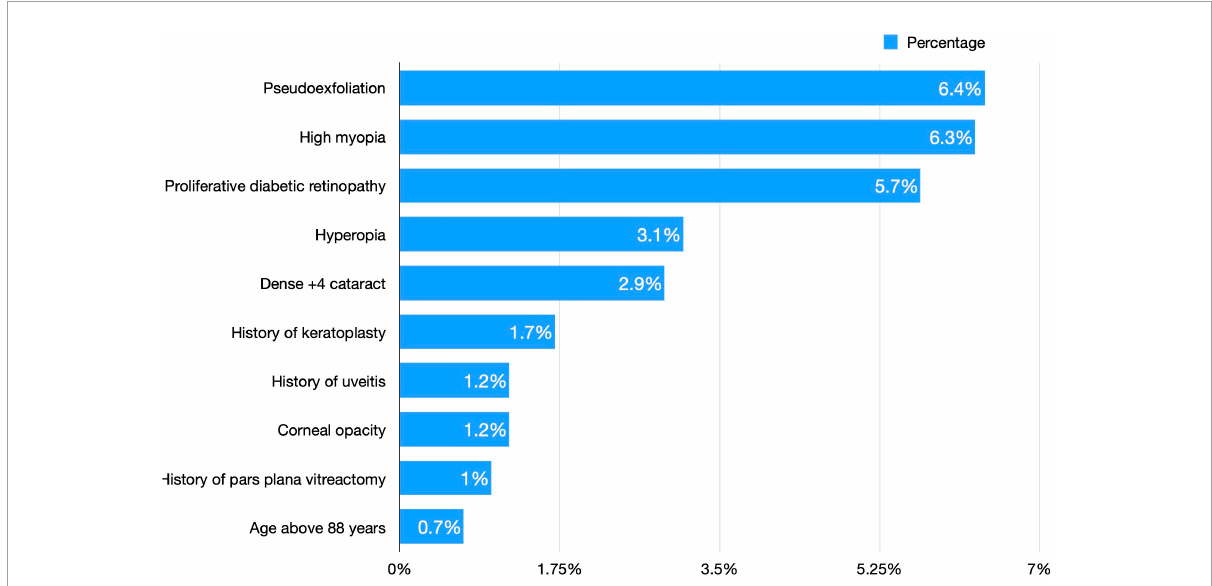
FIGURE2 A comparison of surgery difficulty between consultants and residents who performed phacoemulsification surgeries.